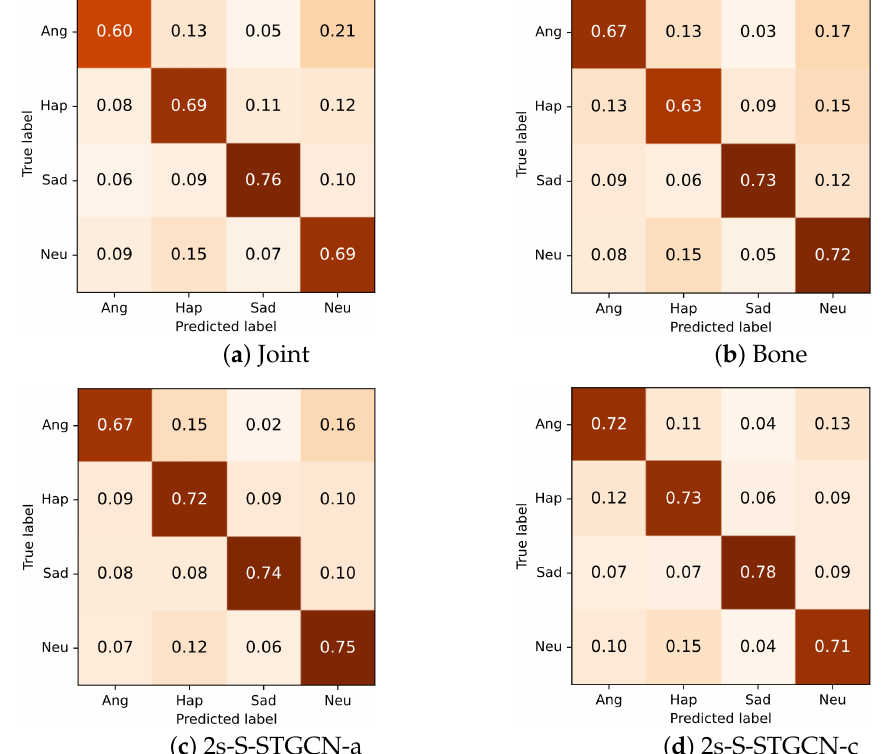
Figure 9. Confusion matrices for single-stream and two-stream